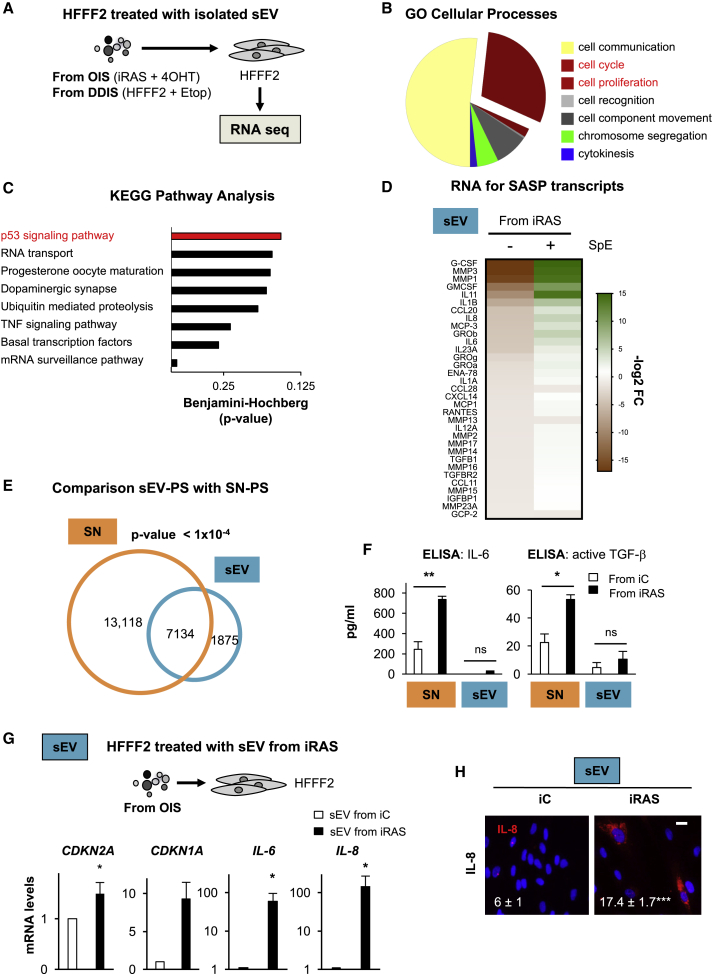
Transcriptome Analysis Shows that sEVs Induce a Senescent Signature(A) Schematic representation of the experimental setting where HFFF2s were treated for 72 h, with sEVs isolated from iRAS cells (mimicking OIS) or HFFF2s treated with Etop (mimicking DDIS) and sent for RNA sequencing.(B) Gene Ontology (GO) analysis for genes involved in cellular processes with >2 log2 fold differential expression and p < 0.05 in both OIS- and DDIS-treated HFFF2s. The pie chart shows a high proportion of genes related to the “cell-cycle” and “cell proliferation” pathways.(C) Kyoto Encyclopedia of Genes and Genomes (KEGG) pathway analysis shows the “p53 signaling pathway” as representative upon HFFF2 treatment with sEVs isolated from senescent cells (from both OIS and DDIS).(D) Bioinformatics analysis of SASP mRNA transcripts in HFFF2 treated with sEVs from iRAS and iC cells. The upregulation of SASP transcripts is prevented when iRAS cells were treated with 5 μM spiroepoxide (SpE; inhibitor of the enzyme neutral sphingomyelinase N-SMase). Data have been normalized to the control and represent the reads per kilobase million (RPKM)-log2 fold difference.(E) Comparison between the paracrine senescence (PS) signature identified by Acosta et al. (2013) by soluble factors (SN) with the sEV-PS signature.(F) ELISA to determine the concentration of IL-6 and active TGF-β present in the SN and sEV lysed fractions.(G and H) HFFF2 treated with sEVs derived from iRAS cells induce an upregulation of cell-cycle inhibitors (CDKN2A, CDKN1A) and SASP (IL-6, IL-8) at the mRNA level, as shown by qPCR analysis (G) and an increase in the percentage of cells staining positive for IL-8 by IF (H). Scale bar, 30 μm.All data represent means ± SDs of 2–4 experiments.See also Figure S2.